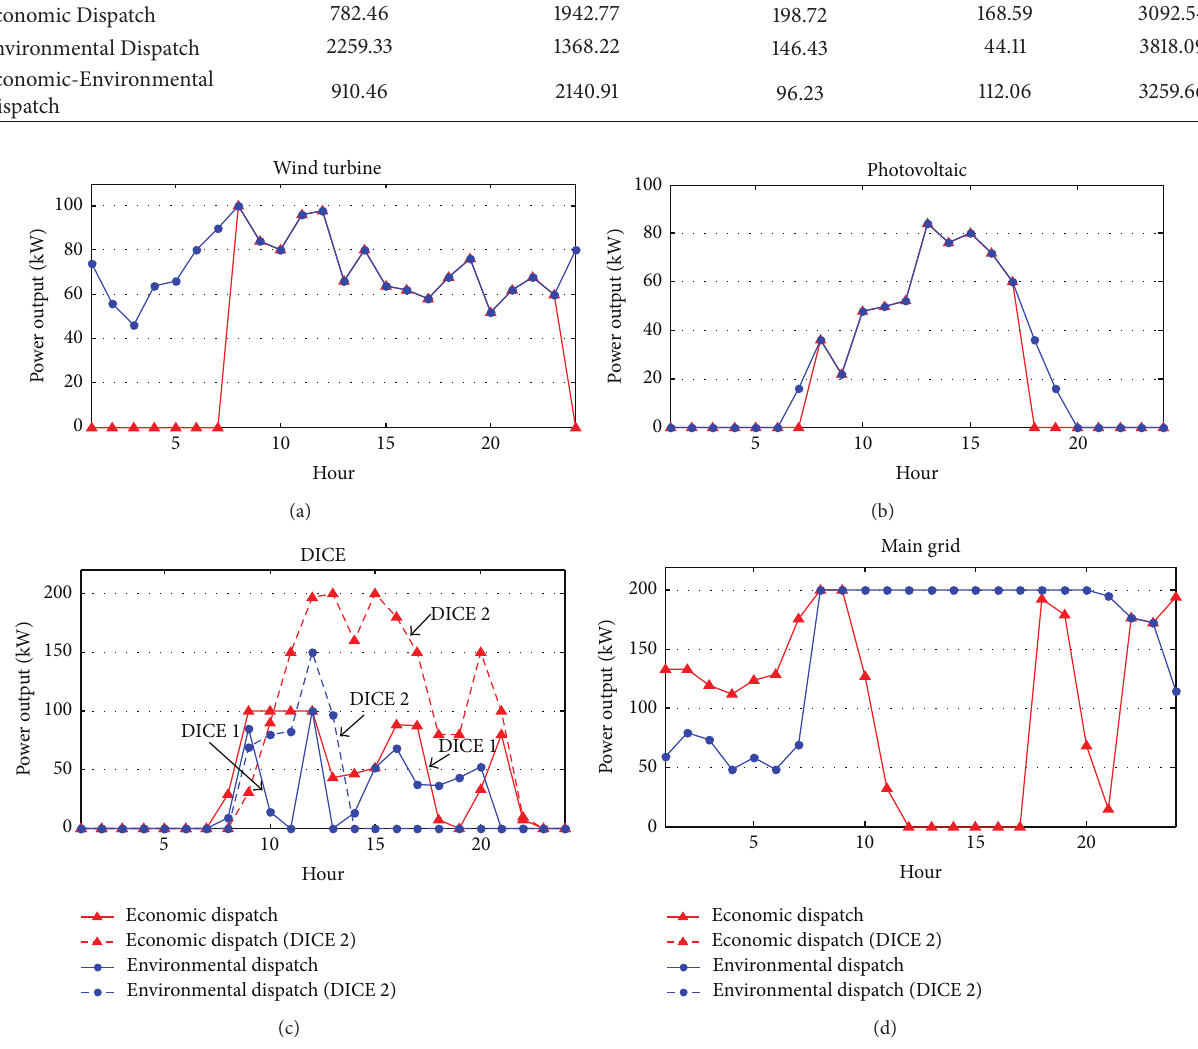
Figure 6: Power sour output under two different paradigms with V = 0 and V = 1